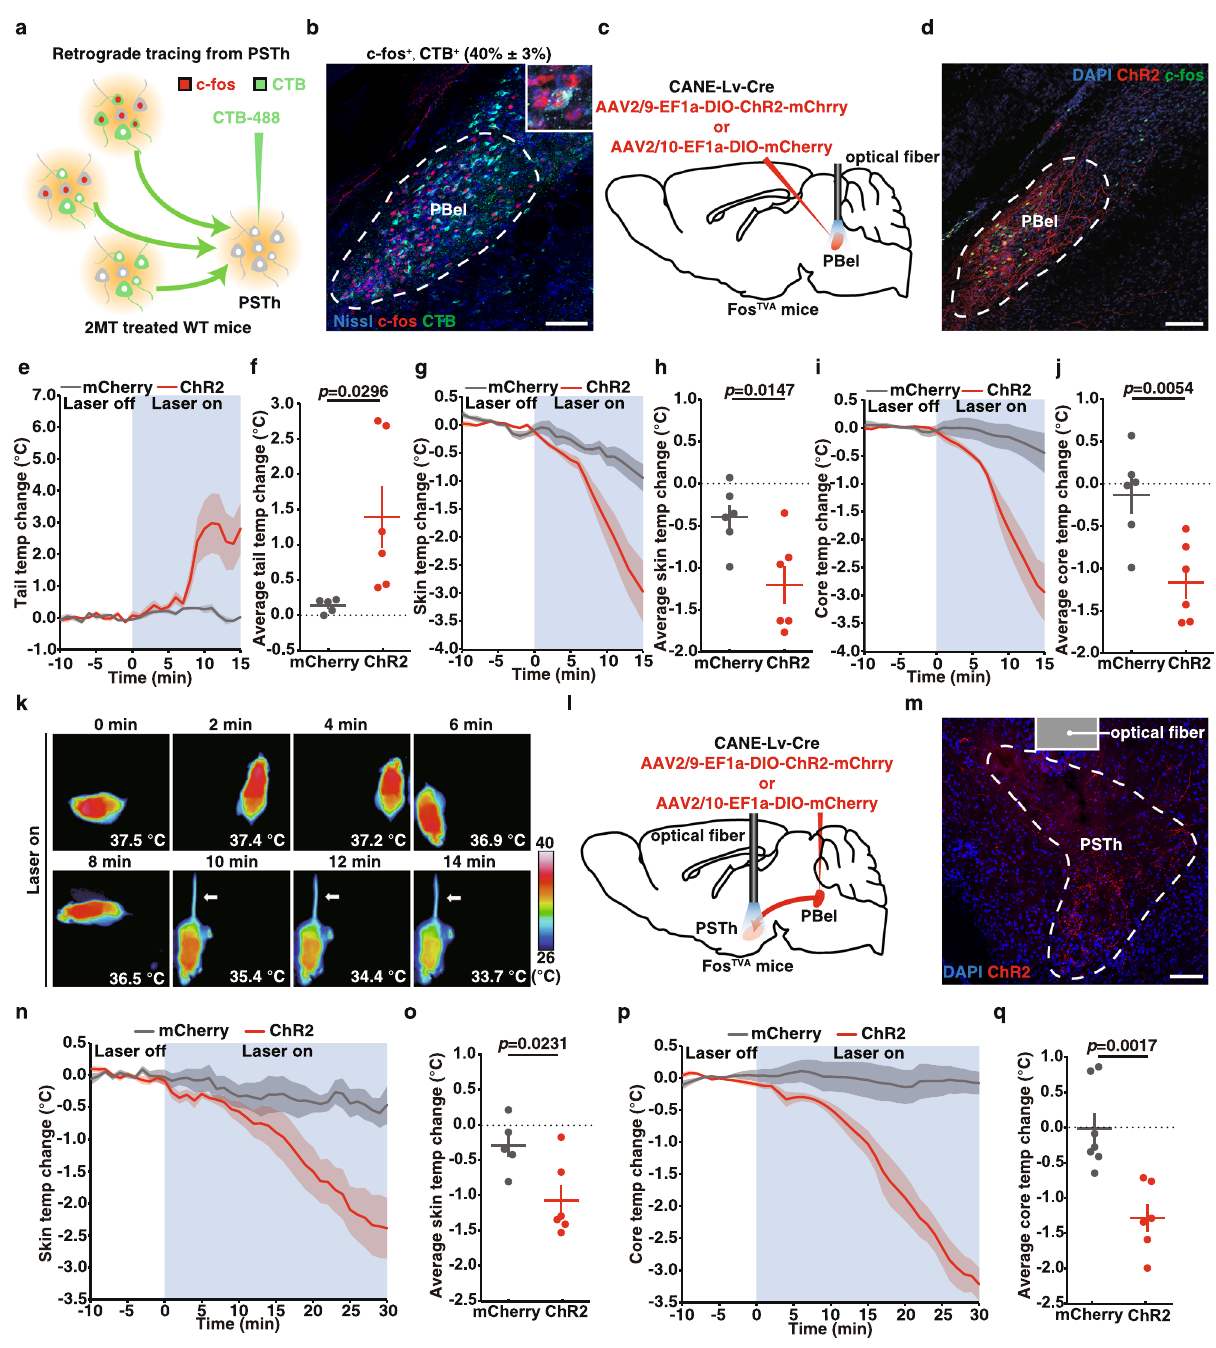
Fig. 6 Activation of 2MT-activated PBel neurons and their axonal inputs to PSTh evokes hypothermia. a Schematic of retrograde tracing from PSTh neurons by CTB. b Representative images showing double immunostaining of CTB and c-fos. The percentage of c-fos + , CTB + neurons among CTB + neurons in PBel is shown in parenthesis ( n = 5). c Schematic of selective opto-stimulation of the cell bodies of 2MT-activated PBel neurons labeled by CANE in Fos TVA mice. d Representative images showing c-fos expression in the ChR2-labeled PBel neurons following photoactivation ( n = 2). Tail ( e ), skin ( g ), and core ( i ) temperature curves of mCherry-expressing ( n = 5 or 7) and ChR2-expressing ( n = 6) Fos TVA mice before and during blue light stimulation of 2MT-activated PBel neurons. Average tail ( f ), skin ( h ), and core ( j ) temperature changes of mCherry-expressing ( n = 5 or 7) and ChR2-expressing ( n = 6) Fos TVA mice during opto-stimulation of 2MT-activated PBel neurons. k Time-lapsed thermal images of ChR2-expressing Fos TVA mice during photoactivation of 2MT-activated PBel neurons. l Schematic of selective opto-stimulation of the axon terminals of 2MT-activated PBel neurons in PSTh in Fos TVA mice. m Representative images showing the ChR2-labeled axon terminals from 2MT-activated PBel neurons in PSTh ( n = 2). Skin ( n ) and core ( p ) temperature curves of mCherry-expressing ( n = 5 or 7) and ChR2-expressing ( n = 6) Fos TVA mice before and during blue light stimulation of axon terminals in PSTh. Average skin ( o ) and core ( q ) temperature changes of mCherry-expressing ( n = 5 or 7) and ChR2-expressing ( n = 6) Fos TVA mice during blue light stimulation of axon terminals in PSTh. e – j , n – q Data are mean ± SEM; two-side Student ’ s t test. Scale bars, 100 µ m.